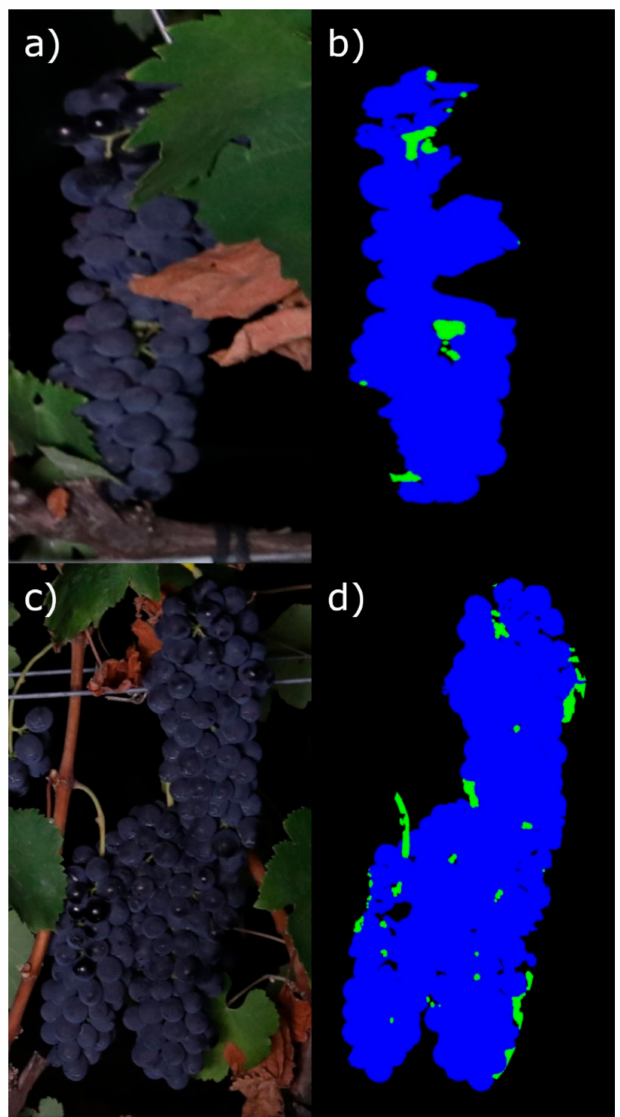
Figure 9. Examples of cluster occlusions and overlapping in commercial vineyards limiting compactness estimation. Clusterpartiallyoccludedbyleaves( a ), multipleoverlappedclusters( c ), andfinalsegmented masks used for compactness estimation ( b , d